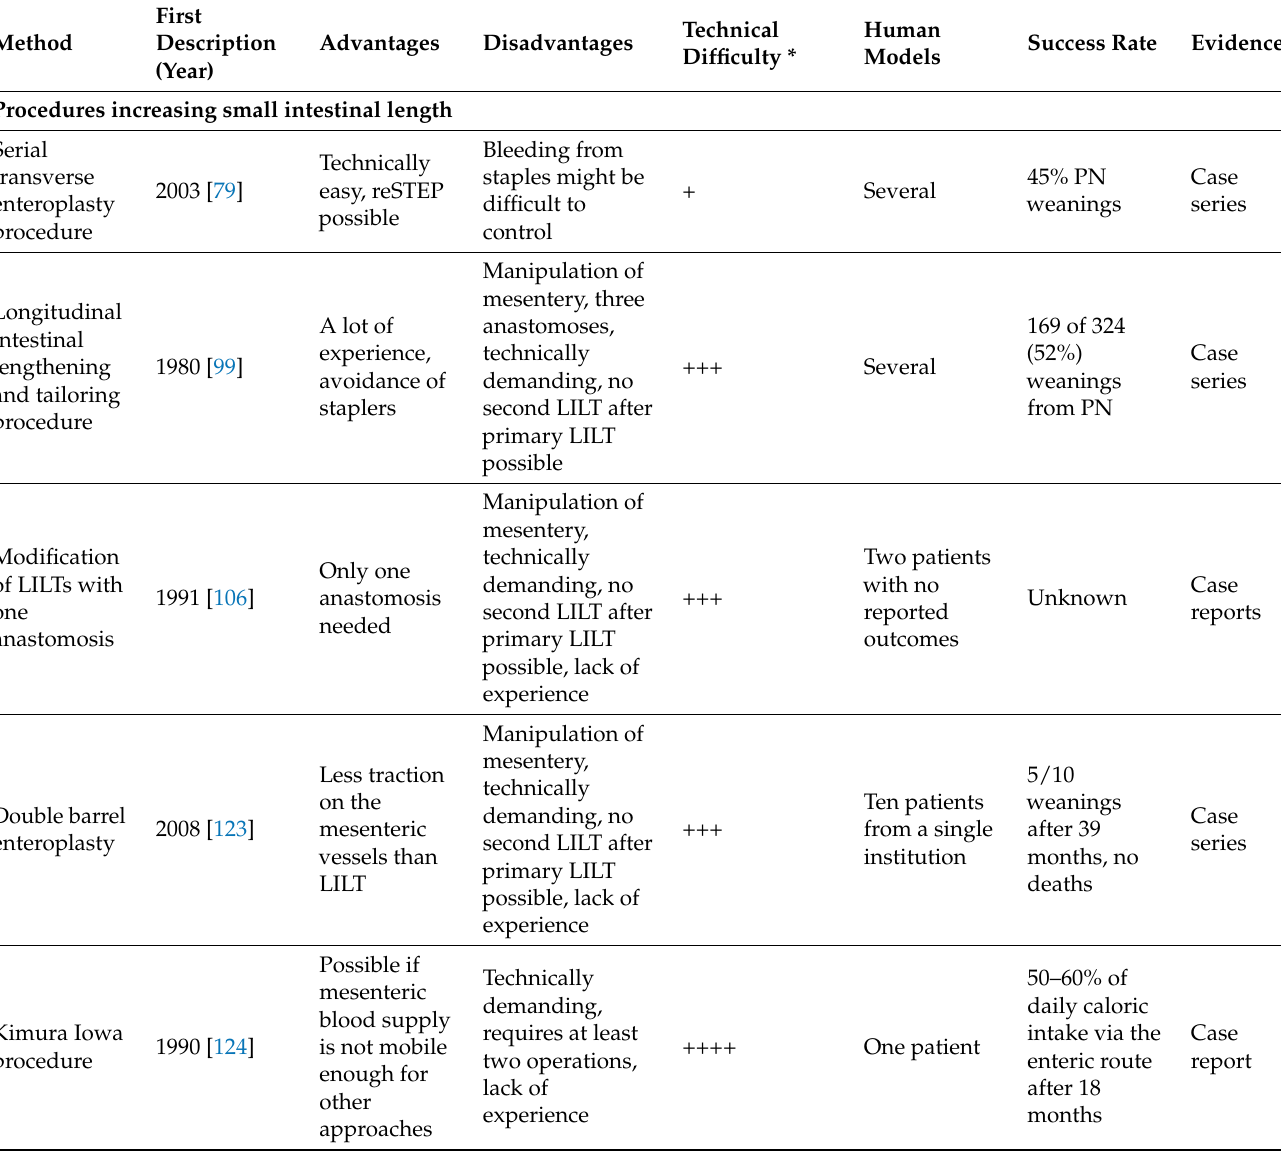
Table 2. Overview over the different treatment